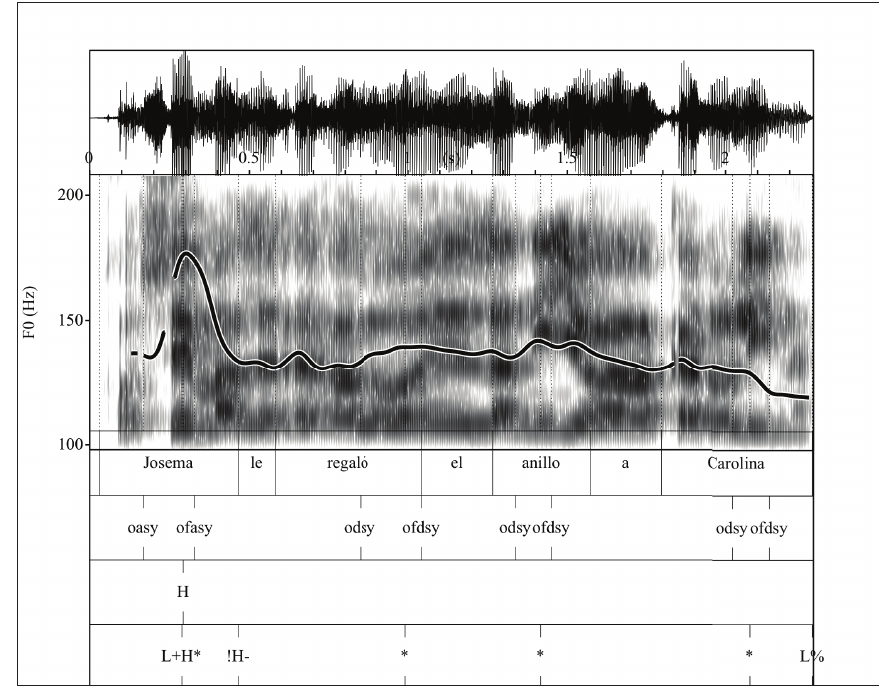
Figure 6: The utterance Josema le regaló el anillo a Carolina ‘Josema gave the ring to Carolina’ as produced by participant 3.